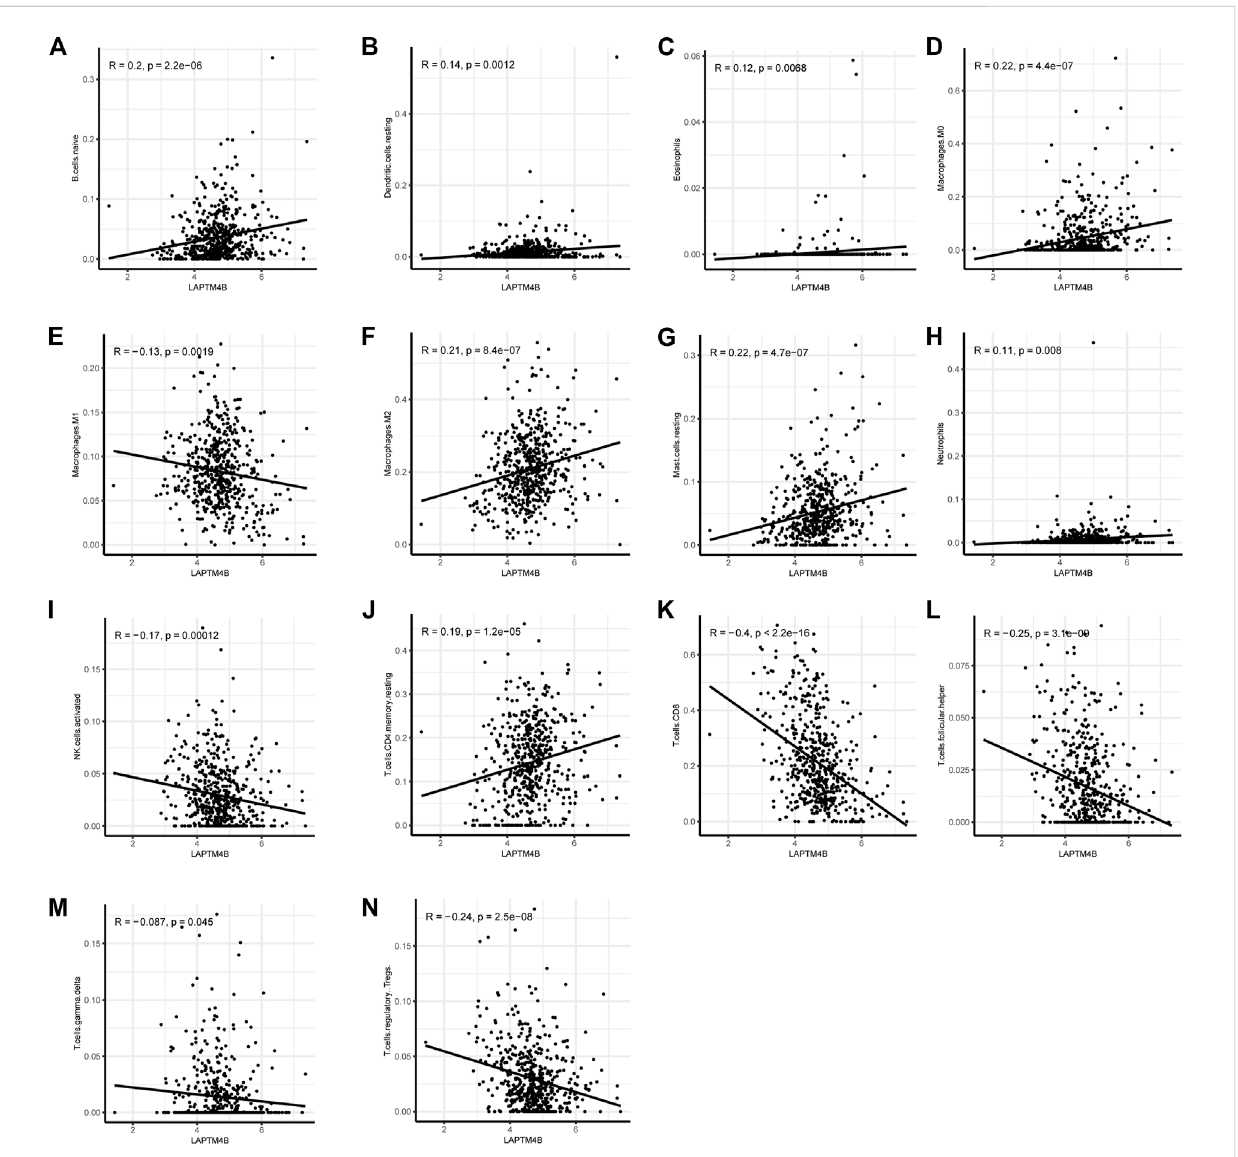
FIGURE 5 Correlation of LAPTM4B and immune cells. Correlation between LAPTM4B and various immune cells, p < 0.05 is the inclusion condition.